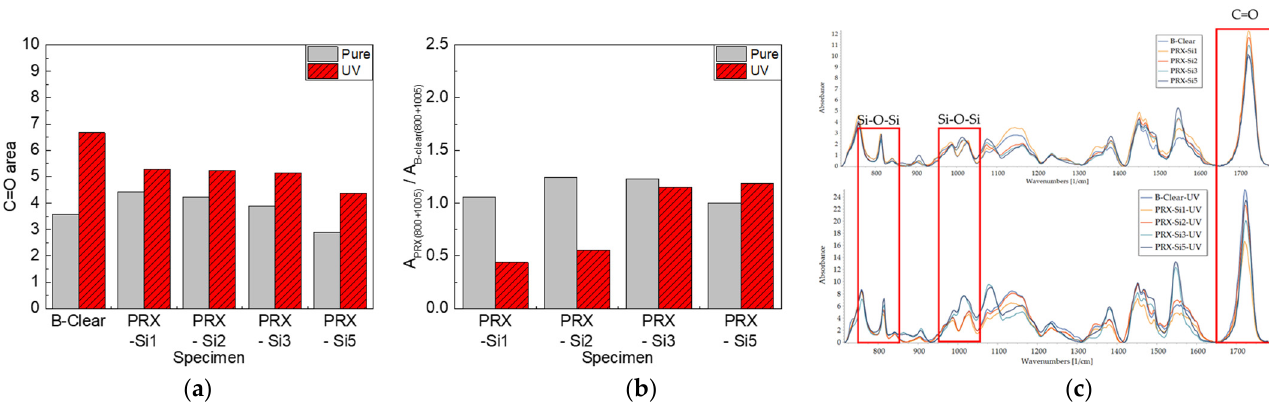
Figure 11. FT-IR analysis results of B-clear and PRX-Si specimens under UV photodegradation conditions. ( a ) Variation of C=O peak area, ( b ) Variation of normalized Si-O-Si peak areas, and ( c ) Comparison of FT-IR spectra.